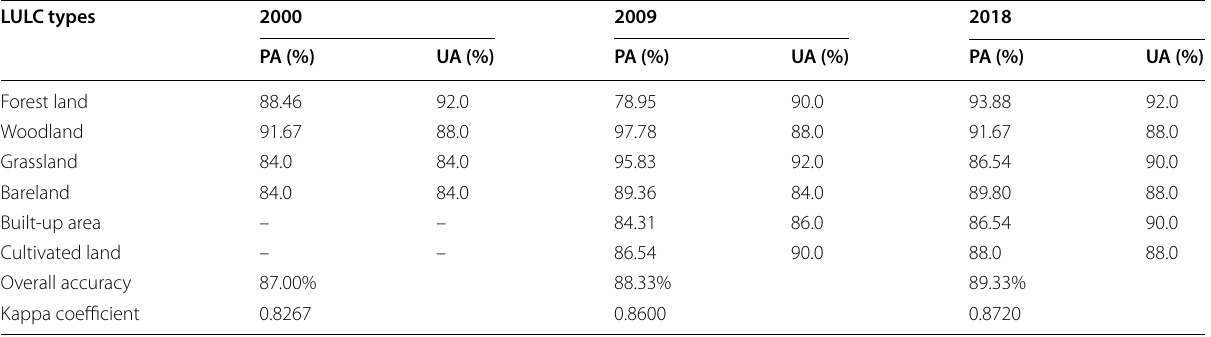
PA producer’s accuracy, UA user’s